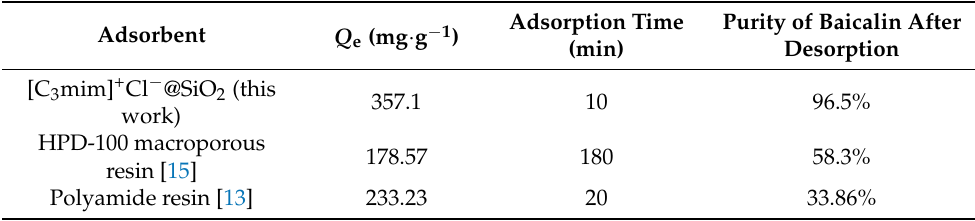
Figure 13. Reusability of [C 3 mim] + Cl − @SiO 2 for the adsorption of baicalin from the root extract of SBG. Experimental conditions: adsorption temperature, 25 ◦ C; adsorption time, 10 min; pH, 5.0; [C 3 mim] + Cl − @SiO 2 , 0.2 g; volume of the root extract of SBG, 10 mL. Experiments were conducted in triplicate. Table 2. Comparison on the adsorption performance between [C 3 mim] + Cl – @SiO 2 and commercial